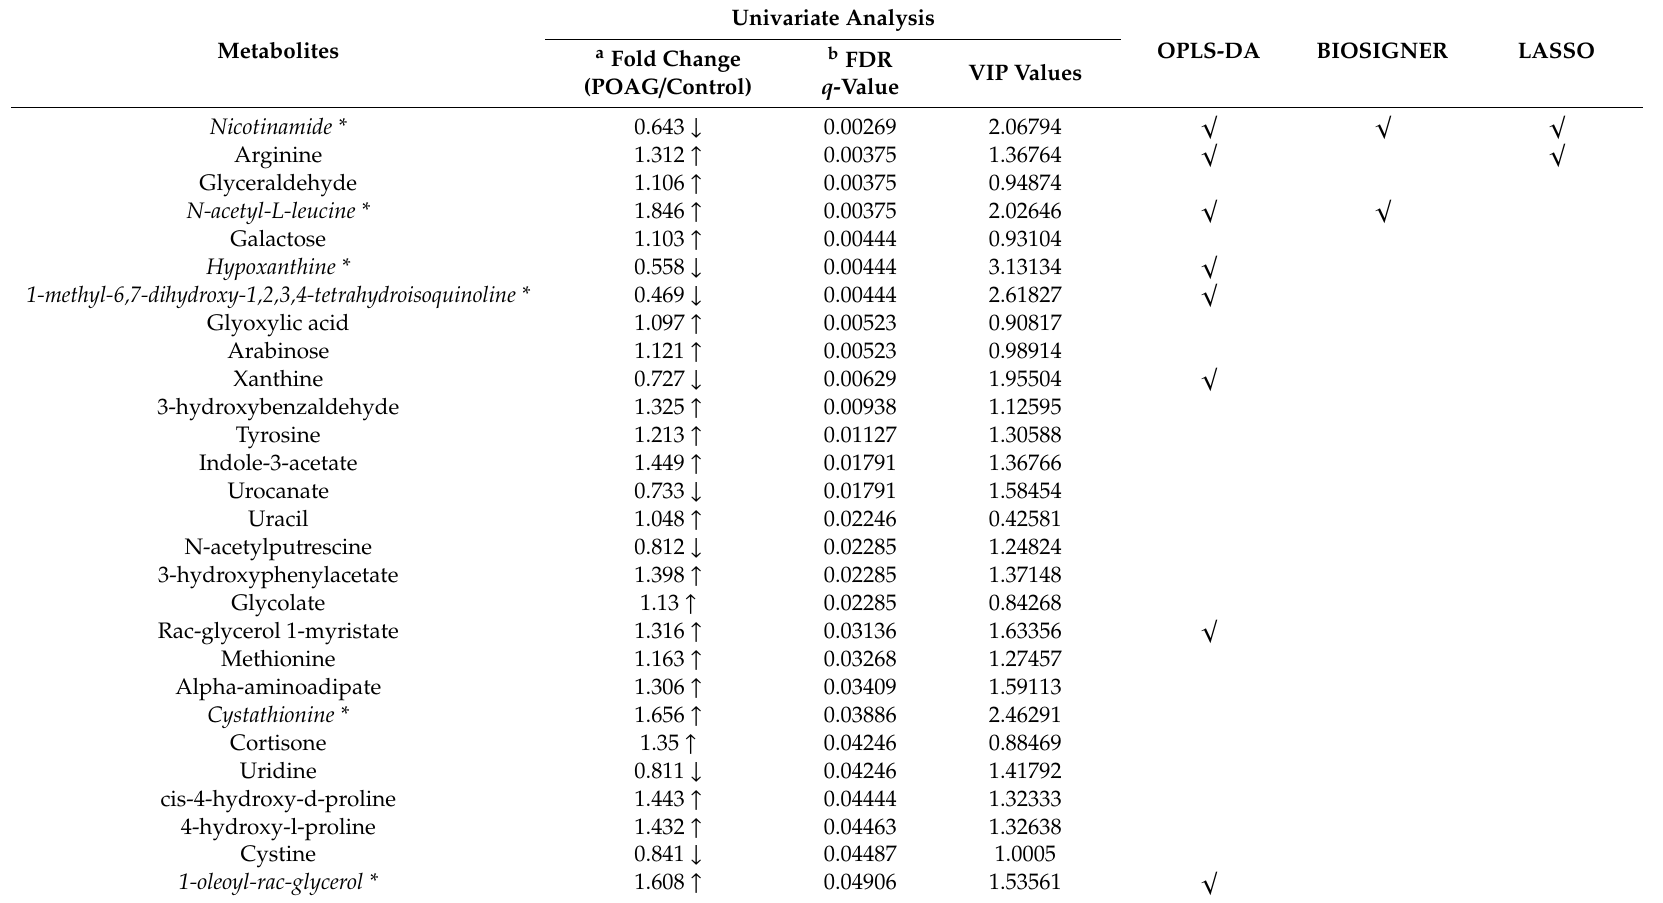
Table 1. Metabolites selection from the 4 statistical